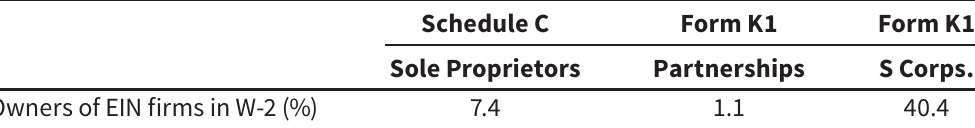
Share of business owners who receive wage and salary